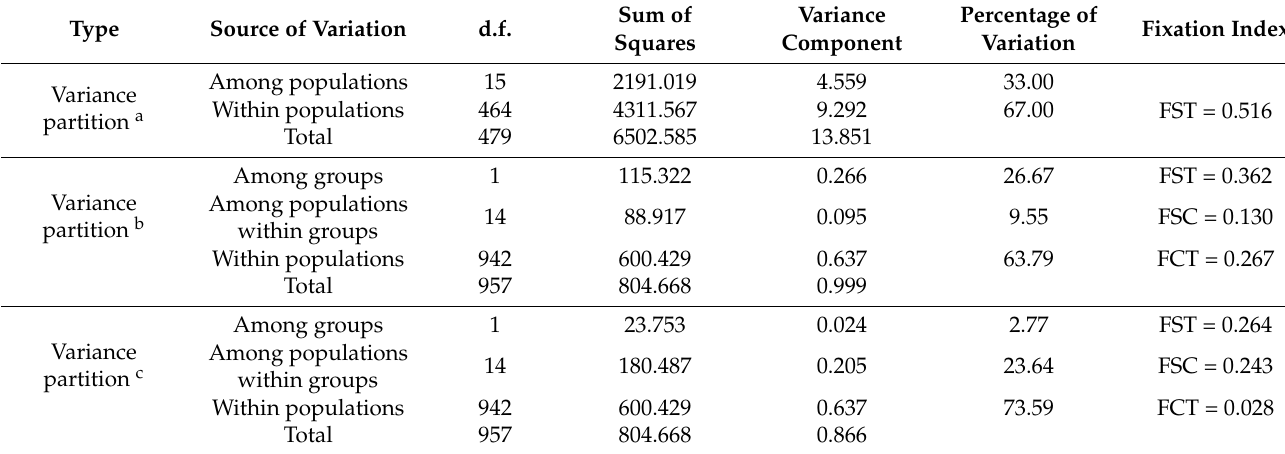
Table 3. Analysis of molecular variance (AMOVA) results for 16 populations of Pinus koraiensis in China.